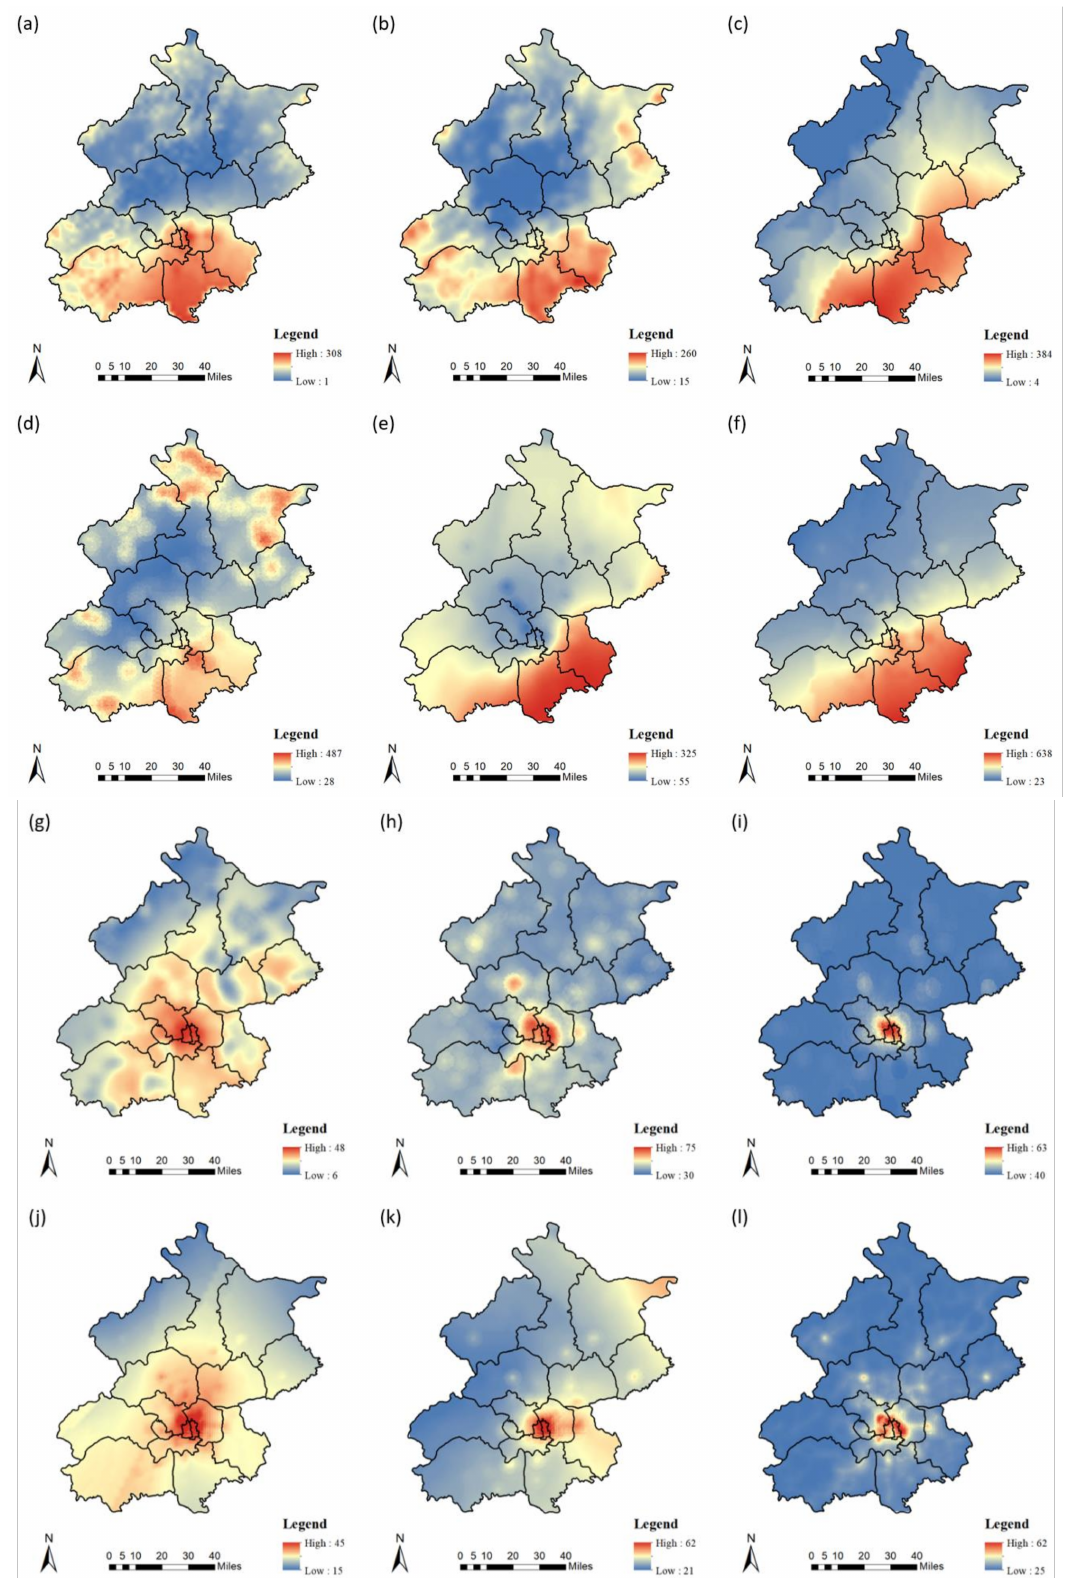
Figure 2. Spatial distribution of PM 2.5 during the different seasons and times. ( a – c ) show the spatial distribution of PM 2.5 during winter working days at 0:00, 8:00, and 18:00; ( d – f ) show the spatial distribution of PM 2.5 during winter non-working days at 0:00, 8:00, and 18:00; ( g – i ) shows the spatial distribution of PM 2.5 during summer working days at 0:00, 8:00, and 18:00; and ( j – l ) shows the spatial distribution of PM 2.5 during summer non-working days at 0:00, 8:00, and